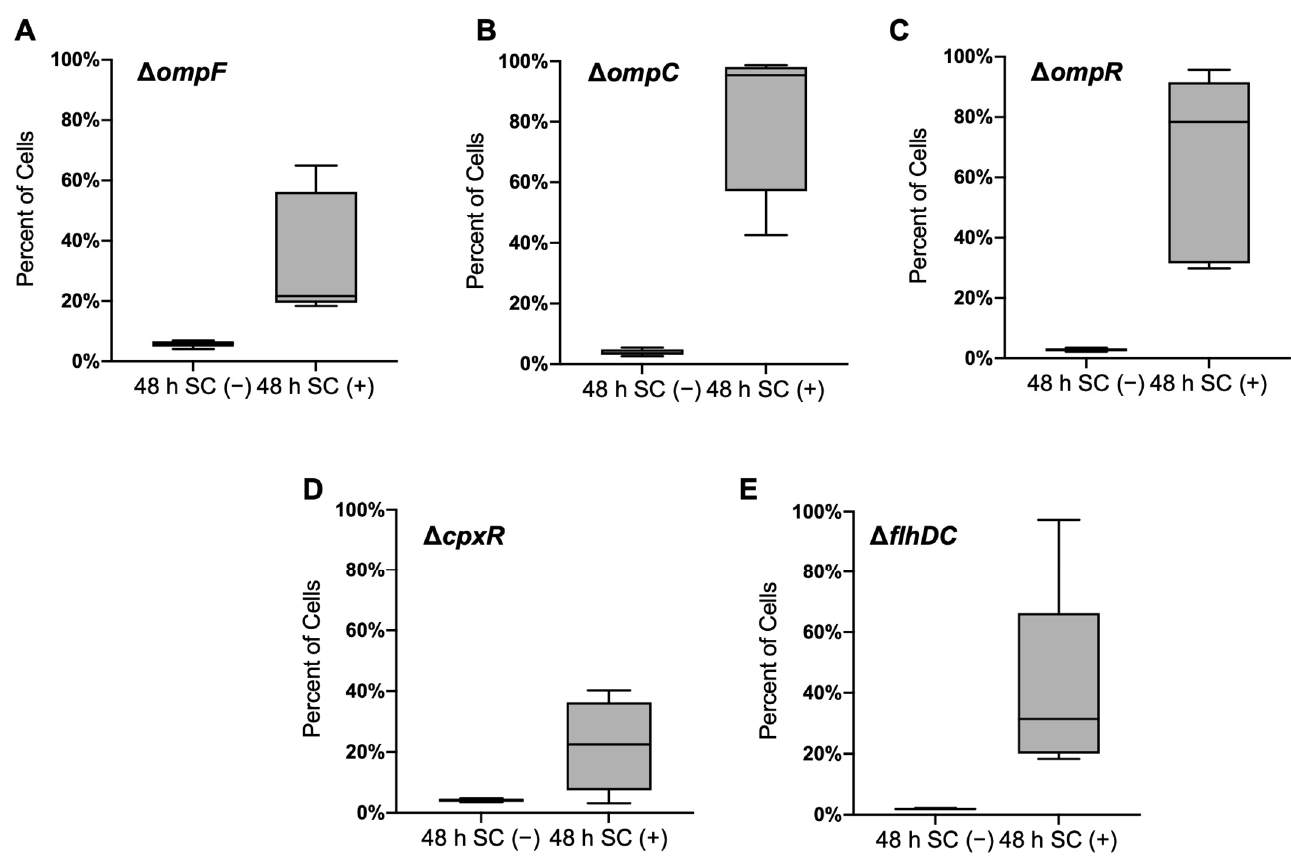
Figure 3. Fractions of rpsL* cells in competition experiments. Overnight cultures of WT Δ ompF with rpsL * Δ ompF ( A ), WT Δ ompC with rpsL * Δ ompC ( B ), WT Δ ompR with rpsL * Δ ompR ( C ), WT Δ cpxR with rpsL * ∆ cpxR ( D ), and WT ∆ flhDC with rpsL * ∆ flhDC ( E ) were 1:1 mixed into the 1